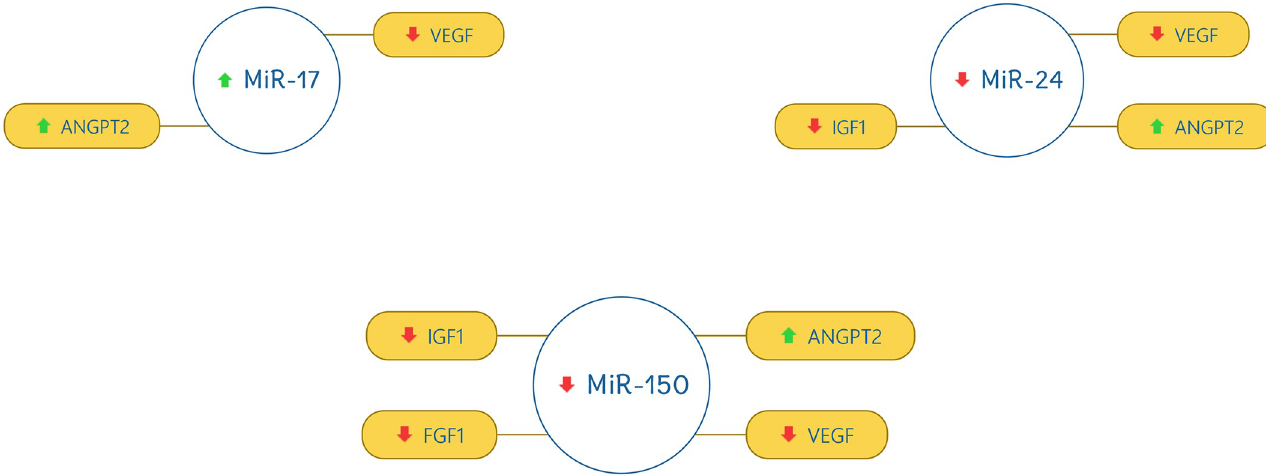
Fig 3. Correlation of miR-17, miR-24, and miR-150 with the selected genes. The red downward arrow shows the down-regulation of genes and the green upward arrow for the up-regulation of genes.